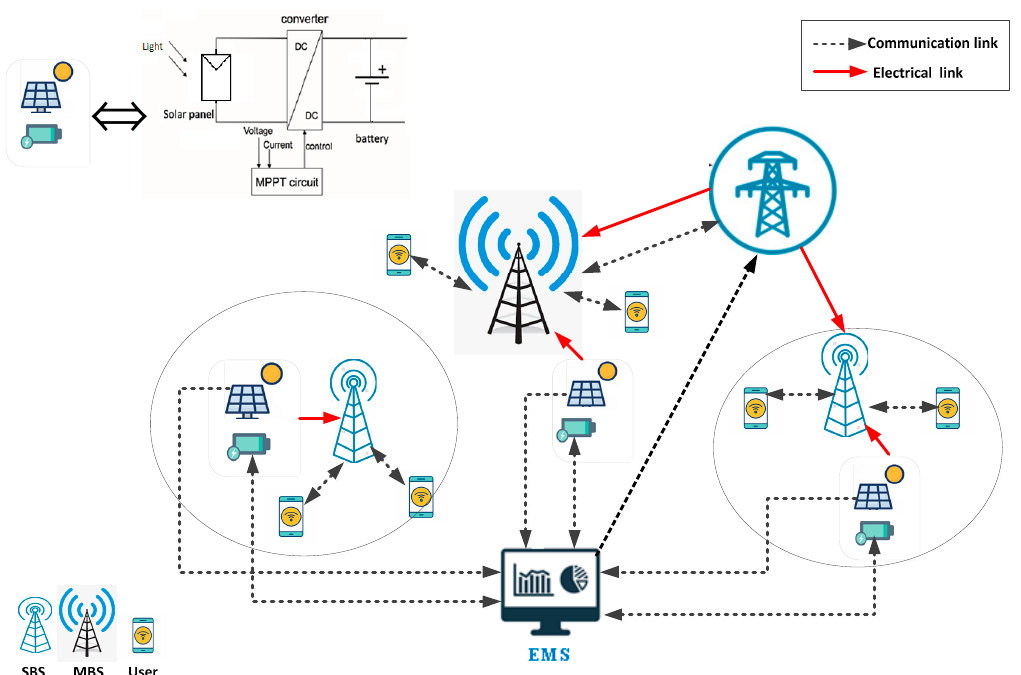
Figure 1. The configuration of next generation cellular telecommunication networks.